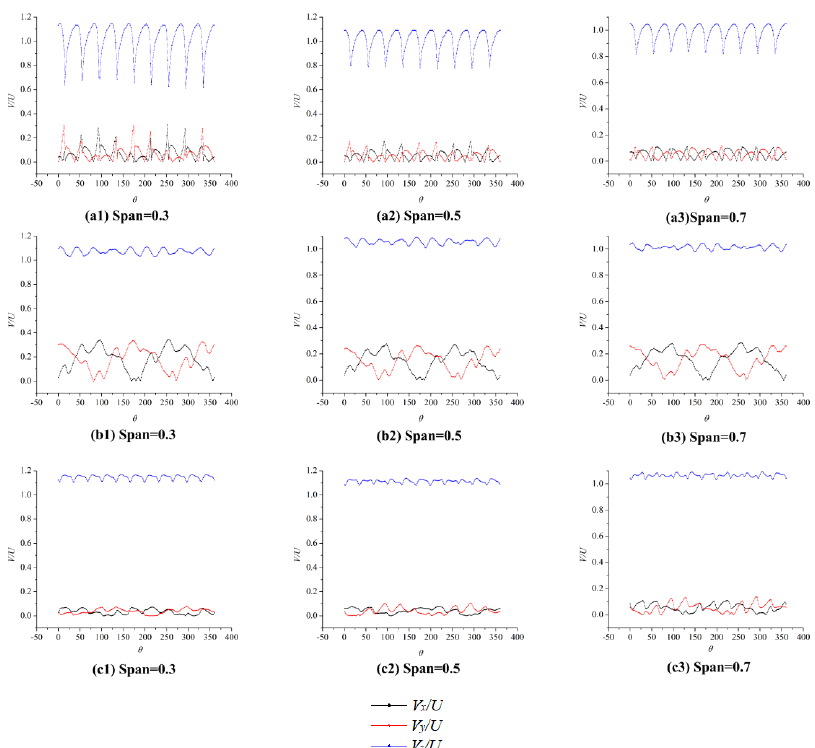
Figure 23. Velocity distribution of pump-jet designed by lifting method ( J = 1.12) (a1, a2, a3 are rotor inlet, b1, b2, b3 are between rotor and stator, c1, c2, c3 are stator outlet). Mathematics 2021 , 9 , x FOR PEER REVIEW